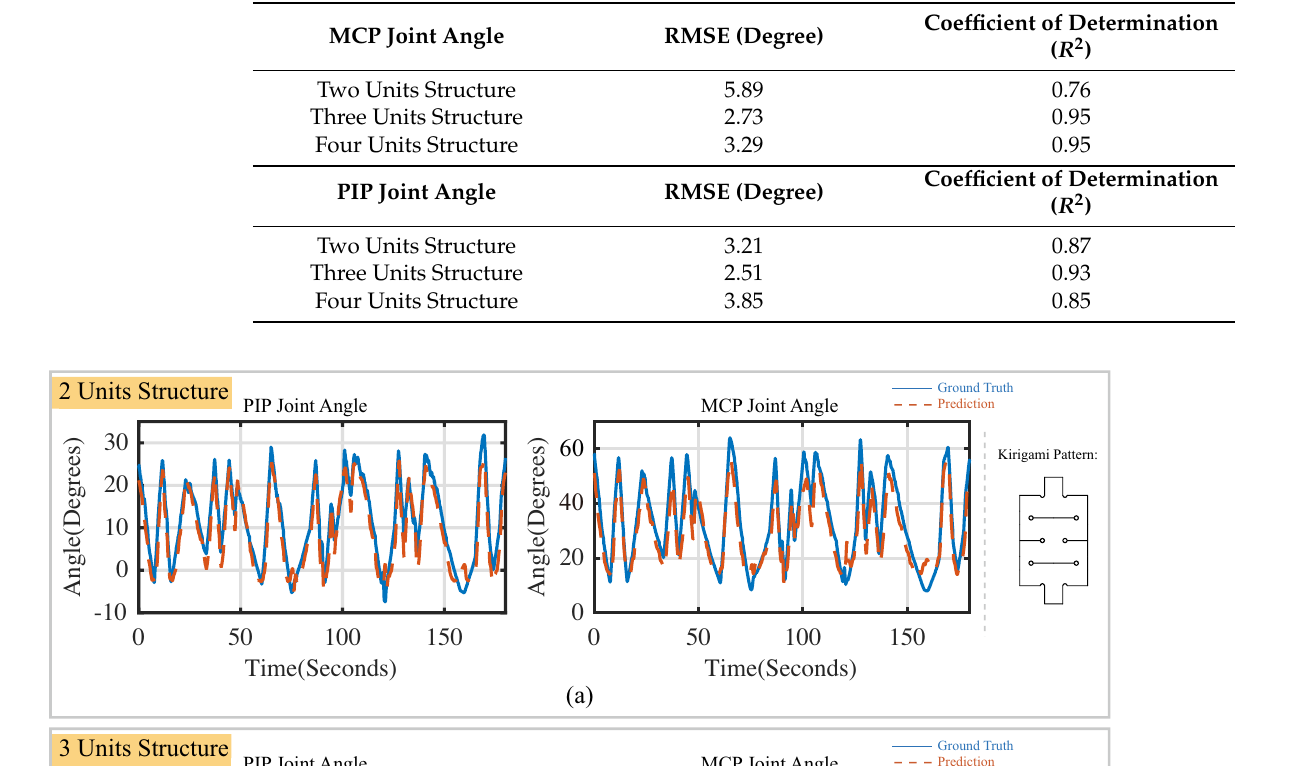
Table 3. Performance of calibration neural network (one-to-one mode).